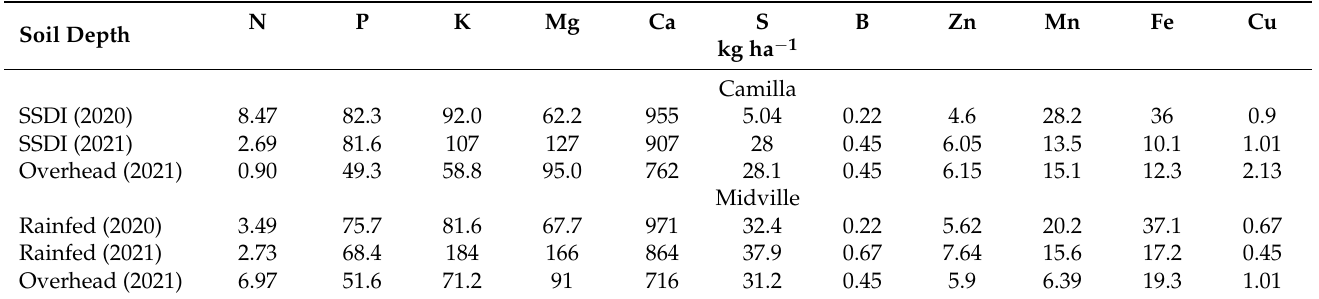
Table 2. Initial nutrient status of the experimental field soil in Camilla and Midville under different production